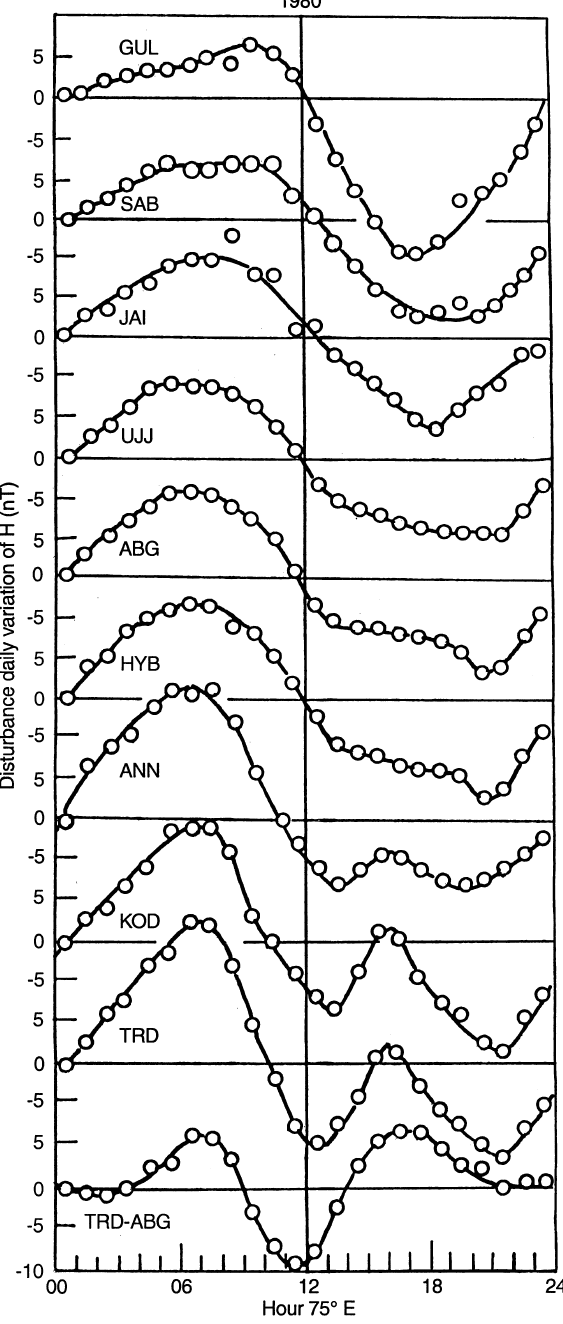
Fig. 1. Disturbance daily variations on H field at Indian observato- ries averaged for all months of the